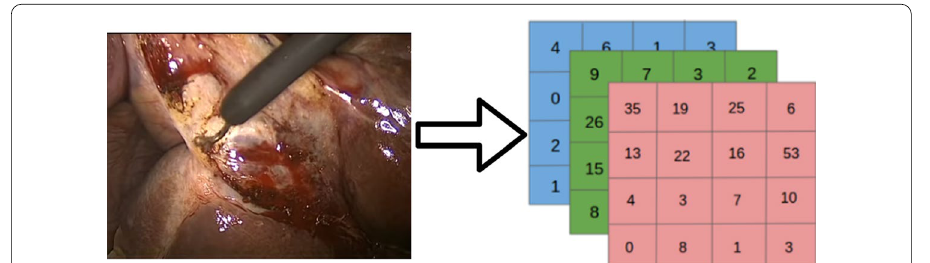
Fig. 2 Image to an array of pixels